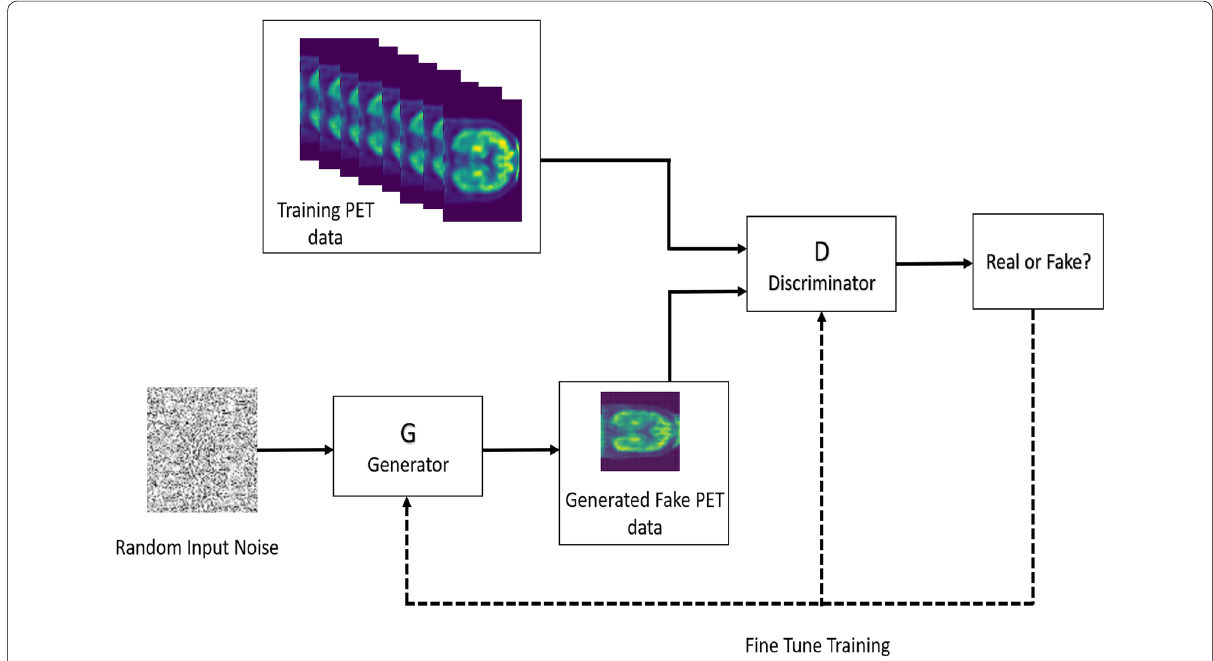
Fig. 2 Proposed synthetic brain PET image